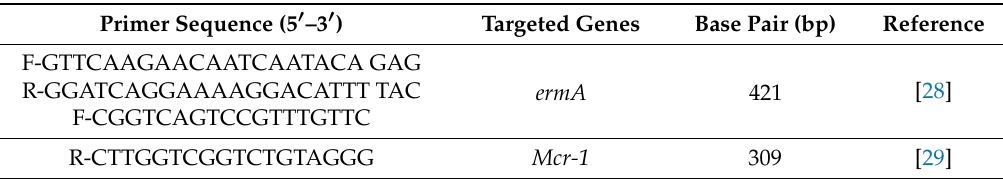
Table 2. Primers sets used in targeting various resistance genes.